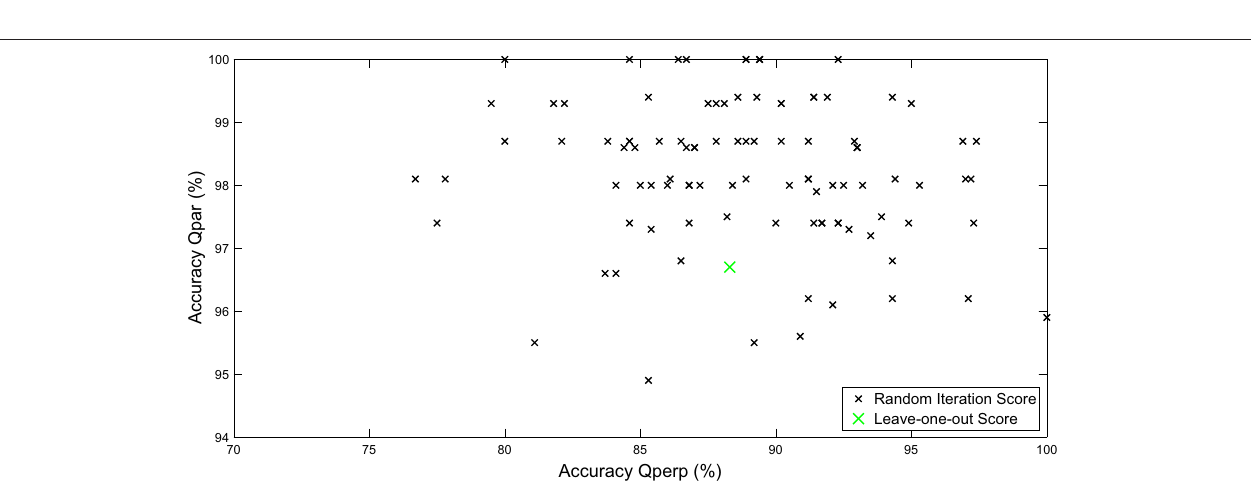
FIGURE 5 | Accuracy of the neural network for 100 different iterations. Left : Results of the quasi-parallel class. Right : Results of the quasi-perpendicular class. The training of the shown neural networks includes the IMF vector.